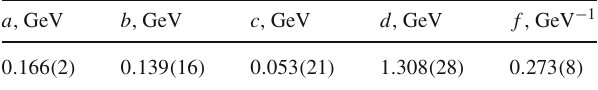
Table1 Theparametersofthechemicalfreeze-out(20),fromRef.[43]. The numbers in brackets give the error estimates in the last digit(s) of the parameters